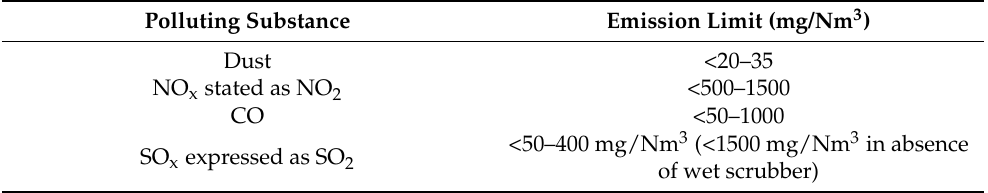
Table 7. Emission limit values according to BAT-AEL [41] for magnesia industry.